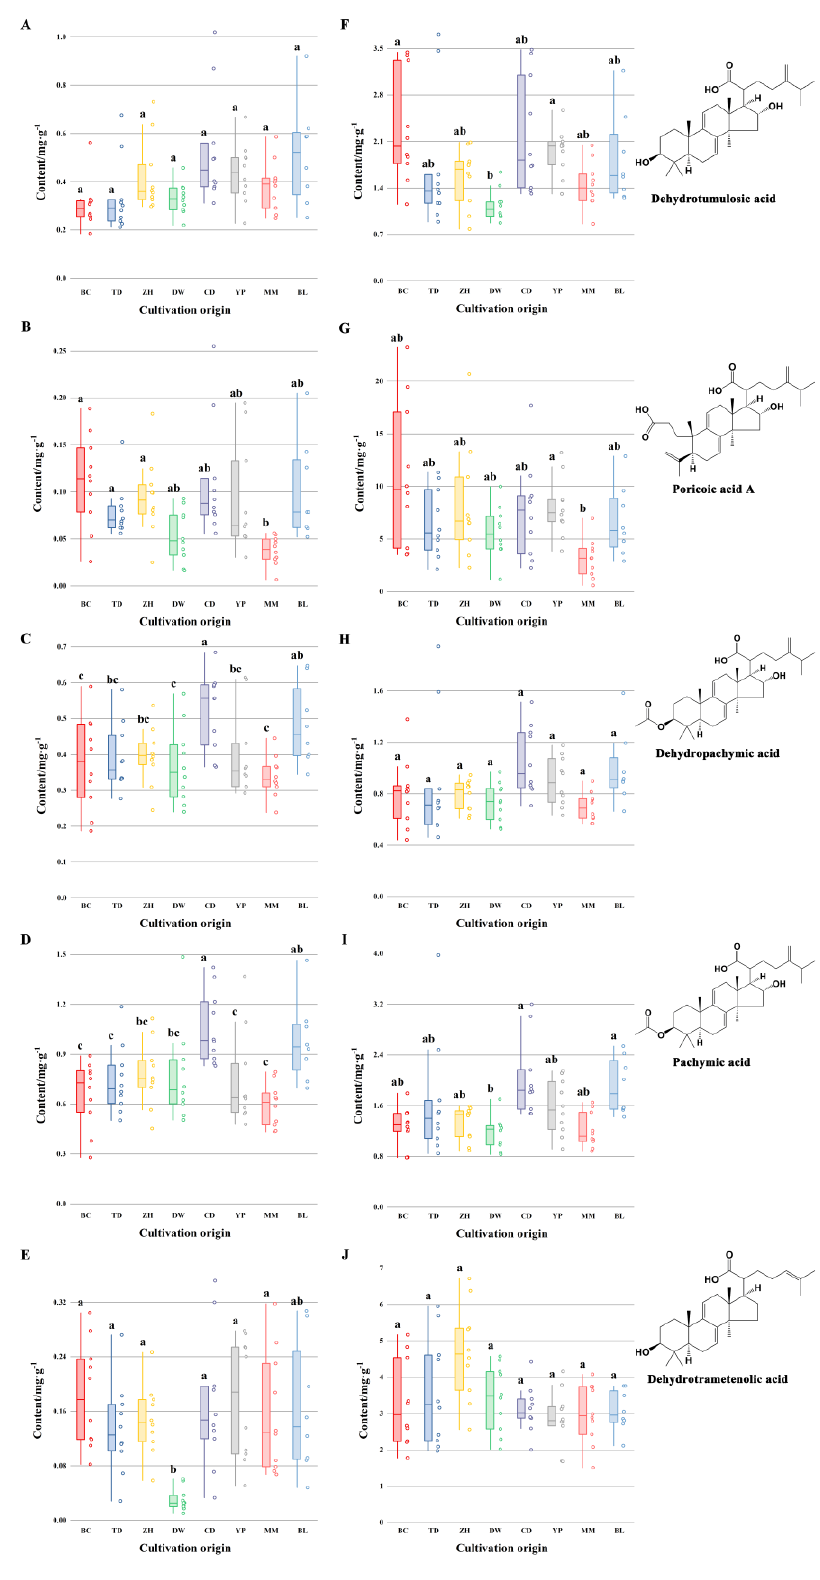
Figure 2. Box-plots of contents of five triterpene acids of Poria ( A – E ) and Poriae Cutis ( F – J ) samples from eight geographical origins. Note: Different letters show significant difference ( p < 0.05).